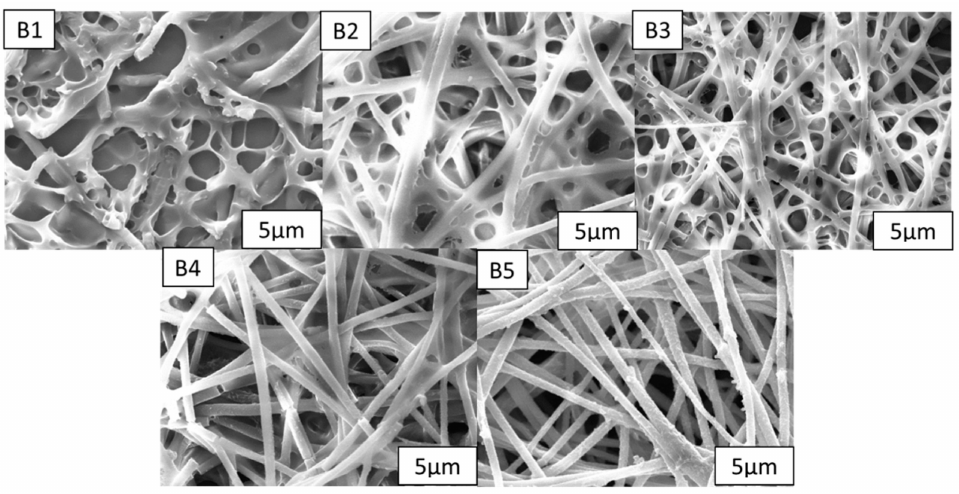
Figure 4. Microscopic morphology of nanofibers of ( b1 – b5 ).